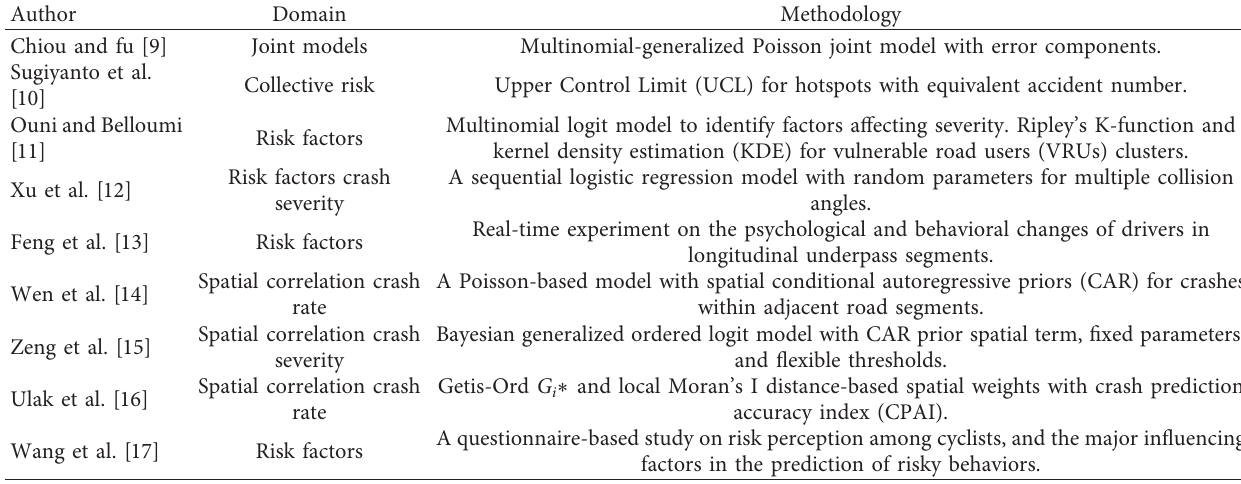
Table 1: Highlights on Crash Risk Analysis (in chronological order).